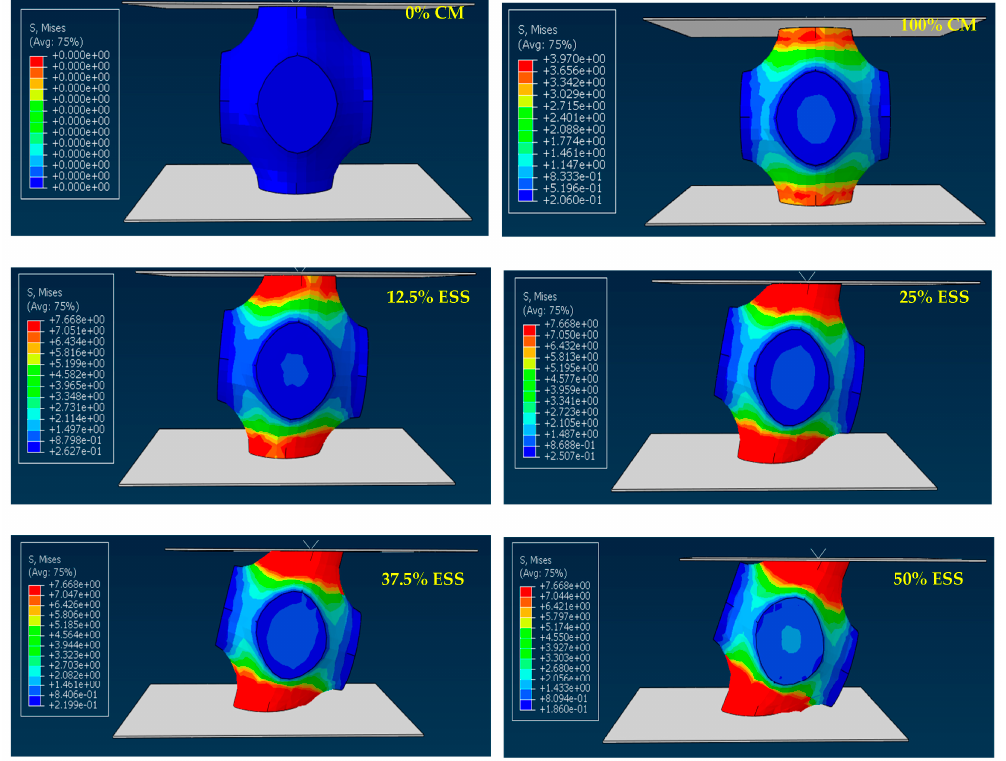
Figure 8. Schematic shear behaviours of the proposed model for monotonic loading procedure at different shear strains with a designed normal pressure of 1 MPa.